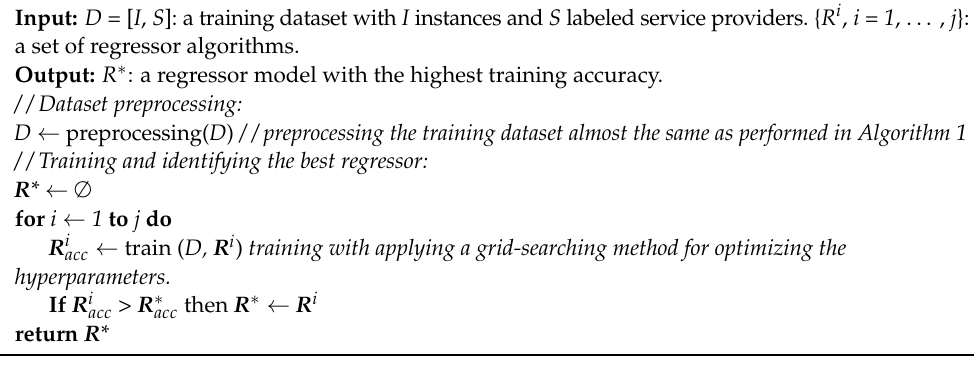
Algorithm 3: Training procedure to select the best training-accuracy regressor, R ∗ .